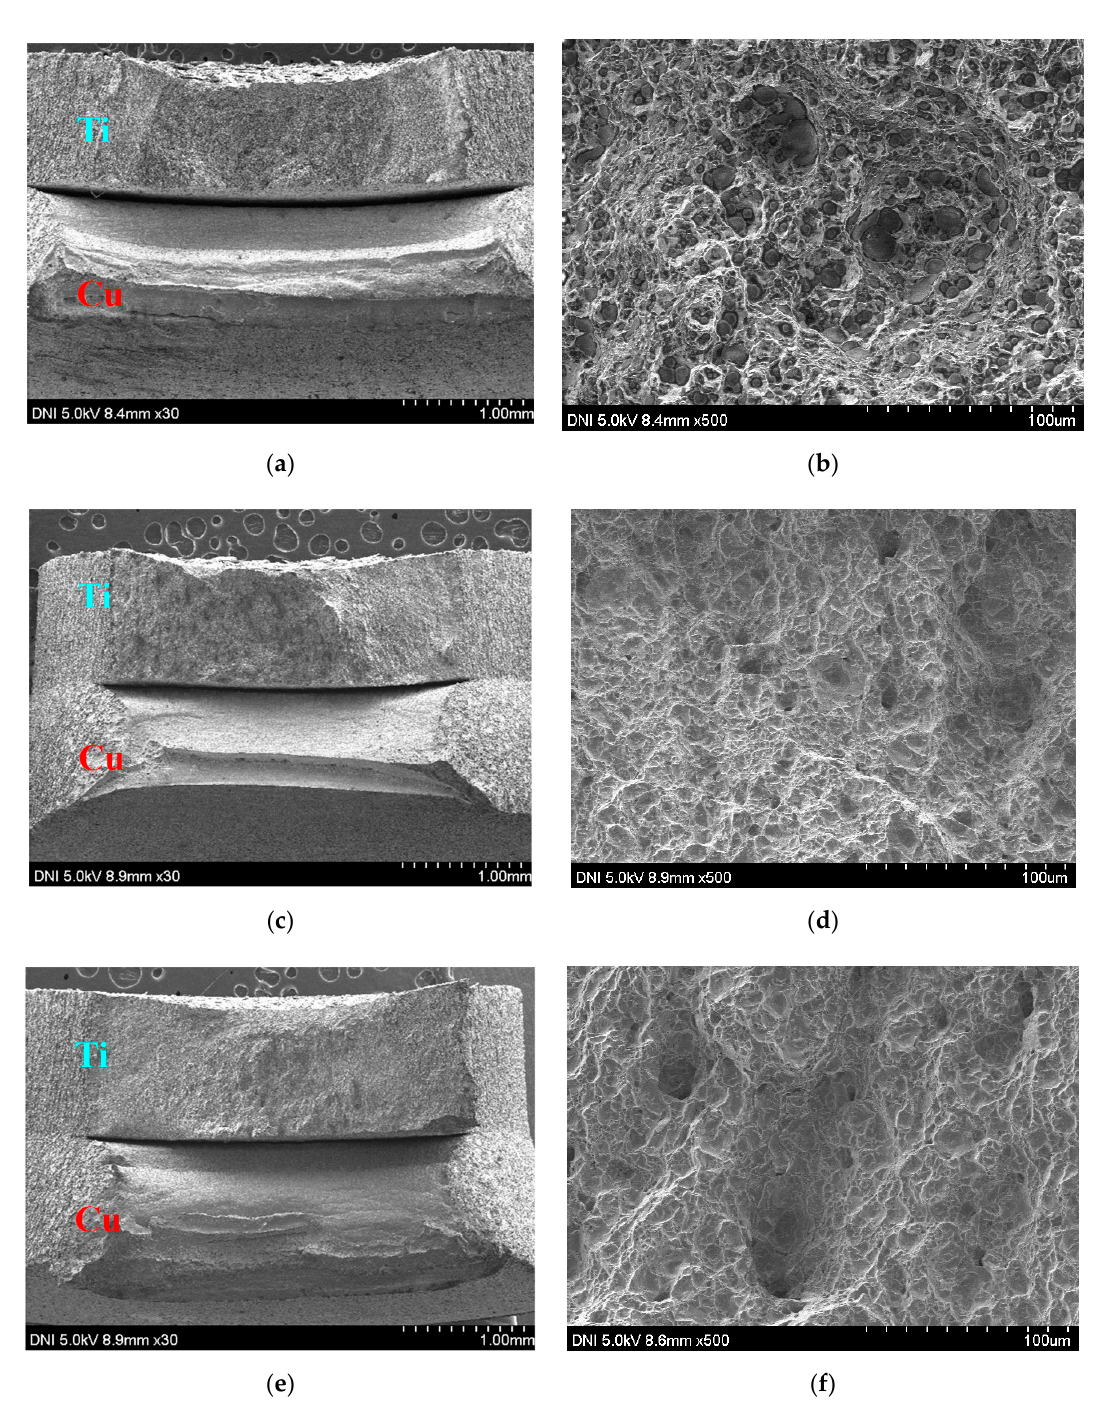
Figure 7. SEM images of fracture surfaces: ( a , b ) as-rolled sample; samples annealed at 450 °C for ( c , d ) 2 h and ( e , f ) 4 h.